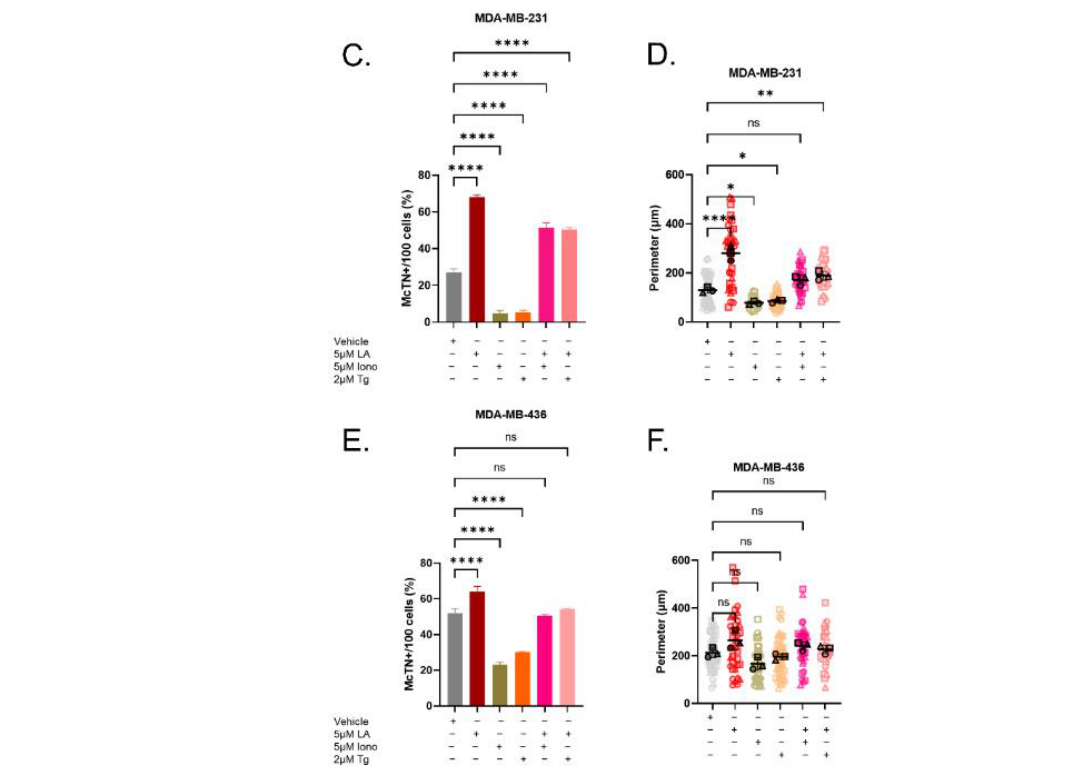
Figure 7. Inhibition of actin polymerization abrogates Ca 2+ -mediated microtentacle suppression in MDA − MB − 231 and MDA − MB − 436 cells. ( A , B ) Representative maximum intensity single cell confocal images (wheat germ agglutinin (WGA) 594 (1:100)) and their black and white contrast counterparts illustrate MDA-MB 231 and MDA-MB-436 cells initially treated with vehicle (0.5% DMSO), 5 µ M Latrunculin A, 5 µ M Ionomycin, 2 µ M Thapsigargin, or the combination of 5 µ M Latrunculin A with 5 µ M Ionomycin or 2 µ M Thapsigargin. Arrows indicating microtentacles on the cell. Scale bar = 5 µ M. ( A ) Images of MDA-MB-231 cells illustrate enhanced McTN formation with 5 µ M Latrunculin A alone or the combination of 5 µ M Latrunculin A with 5 µ M Ionomycin or 2 µ M Thapsigargin. ( B ) Representative images of MDA-MB-436 cells treated with 5 µ M Latrunculin A alone or the combination of 5 µ M Latrunculin A with 5 µ M Ionomycin or 2 µ M Thapsigargin show an elevation of McTN formation. ( C ) Inhibition of actin polymerization alone significantly increases McTN positivity, while the addition Ca 2+ flux by Ionomycin or Thapsigargin under this condition also impedes McTN suppression in MDA-MB-231 cells. ( D ) Whole cell perimeter of MDA-MB-231 cells increases with 5 µ M Latrunculin A treatment alone and with the elevation of cytoplasmic Ca 2+ from 5 µ M Ionomycin and 2 µ M Thapsigargin treatment. ( E ) Inhibition of actin polymerization in MDA-MB-436 cells with 5 µ M Latrunculin A significantly increases McTN positivity alone and in the presence of Ca 2+ flux by Ionomycin or Thapsigargin treatment. ( F ) Whole cell perimeter in MDA-MB-436 cells does not significantly change when treated with 5 µ M Latrunculin A alone and with the elevation of cytoplasmic Ca 2+ from 5 µ M Ionomycin or 2 µ M Thapsigargin treatment. ( C , E ) Data shown as mean ± SD, n = 3. ( D , F ) Data shown as mean ± SD, n = 3, determined from a total of 20 to 30 cells from combined biological replicates. n.s., * p < 0.05, ** p < 0.01, and **** p <